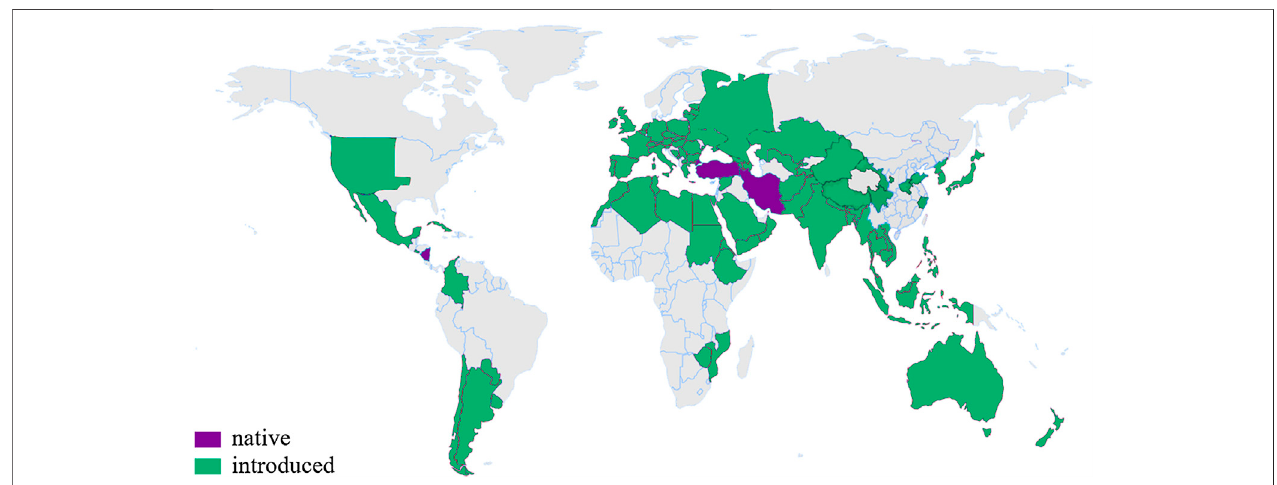
FIGURE 1 | The distribution of saf fl ower in the world (The global planting area is about 1.1 million hm2). According to http://www.plantsoftheworldonline.org/ taxon/urn:lsid:ipni.org:names:324467-2